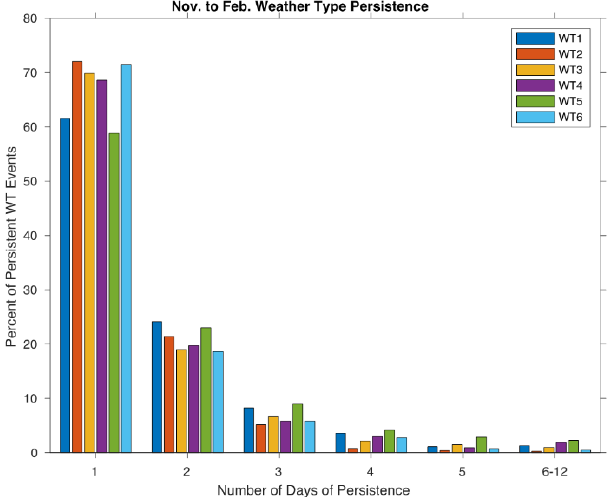
Figure 5. Persistence of the 6 WTs presented by different color bars, respectively. The x-axis is the length of consecutive days with the same WT. The last group of bars is the sums of persistent events of 6 to 12 days.